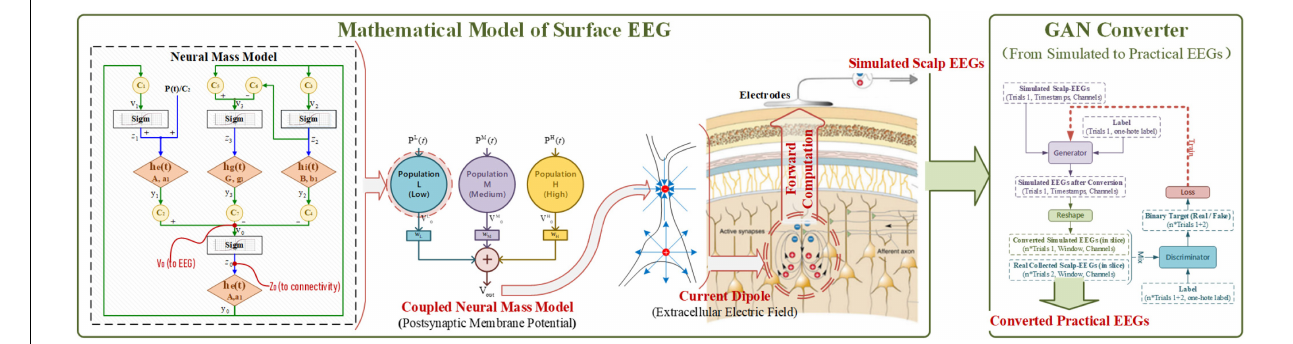
FIGURE 1 | The schematics diagram of methodology.